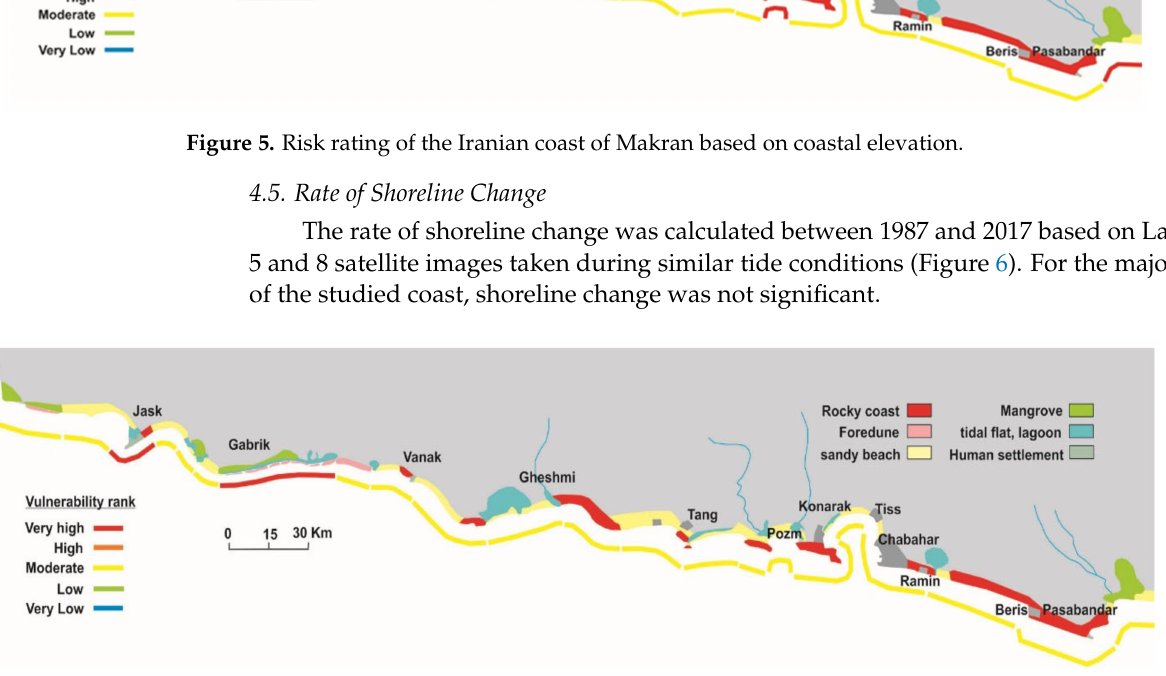
Figure 6. Risk rating of the Iranian coast of Makran based on shoreline changes between 1987 and